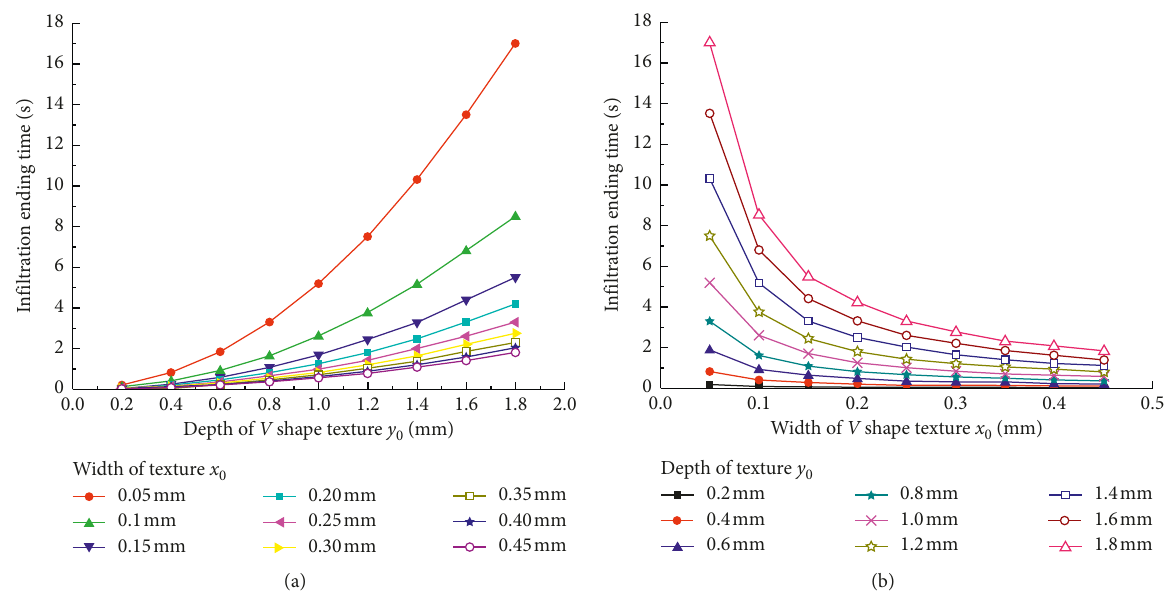
Figure 7: Infiltration ending times with different V shape textures. (a) Infiltration ending time vs. depth of texture. (b) Infiltration ending time vs. width of texture.